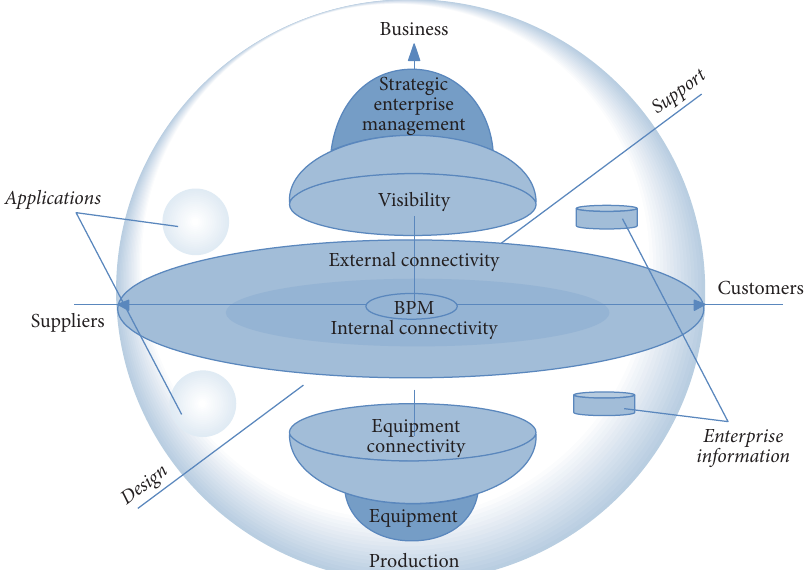
Figure 4: The framework of the collaborative infrastructure. Collaboration must be established between units within the organization as well as between partners and customers outside the organization. Access to equipment and the visibility of strategic management are important at all levels of the structure